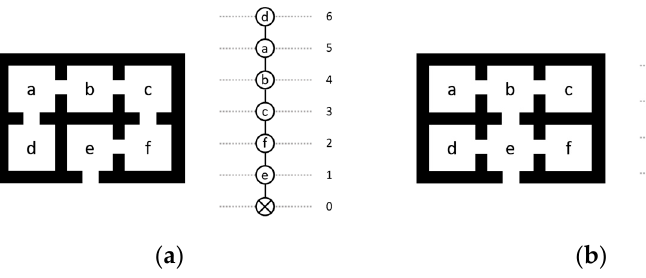
Figure 1. Examples of different justified graph: ( a ) deep tree formed graph model; ( b ) shallow tree formed graph model; ( c ) shallow ringy graph